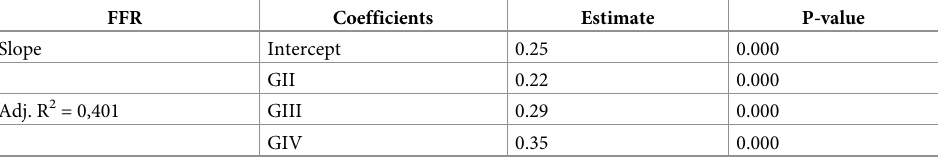
Table 5. Regression analysis of the Frequency-Following Response slope components in relation to age